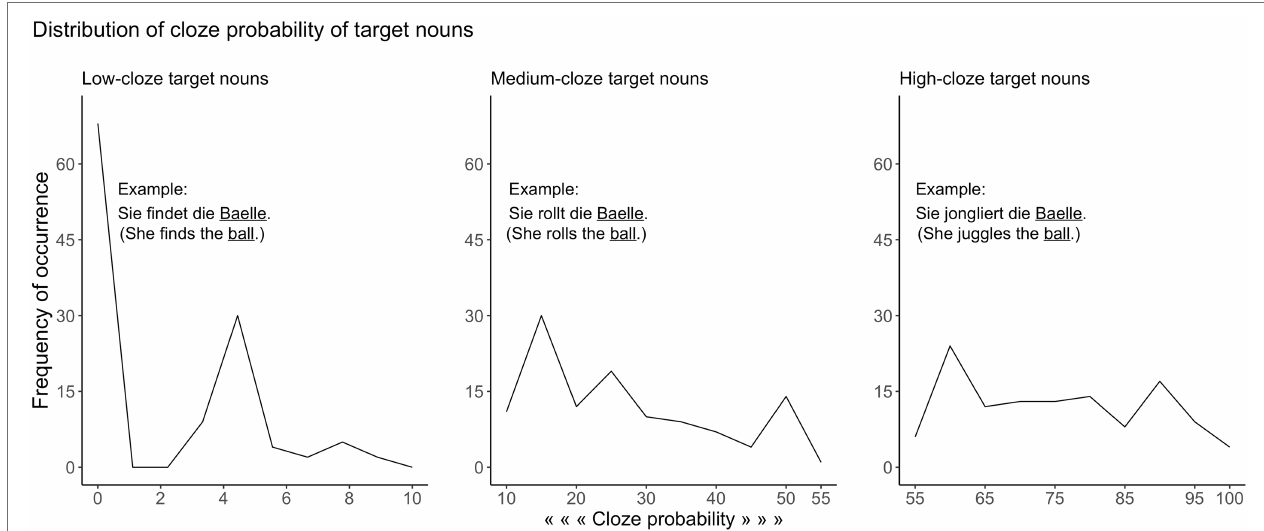
FIGURE 1 | The distribution of cloze probability values for low-, medium-, and high-cloze target nouns. Example sentences with their English translations are shown on each plot.